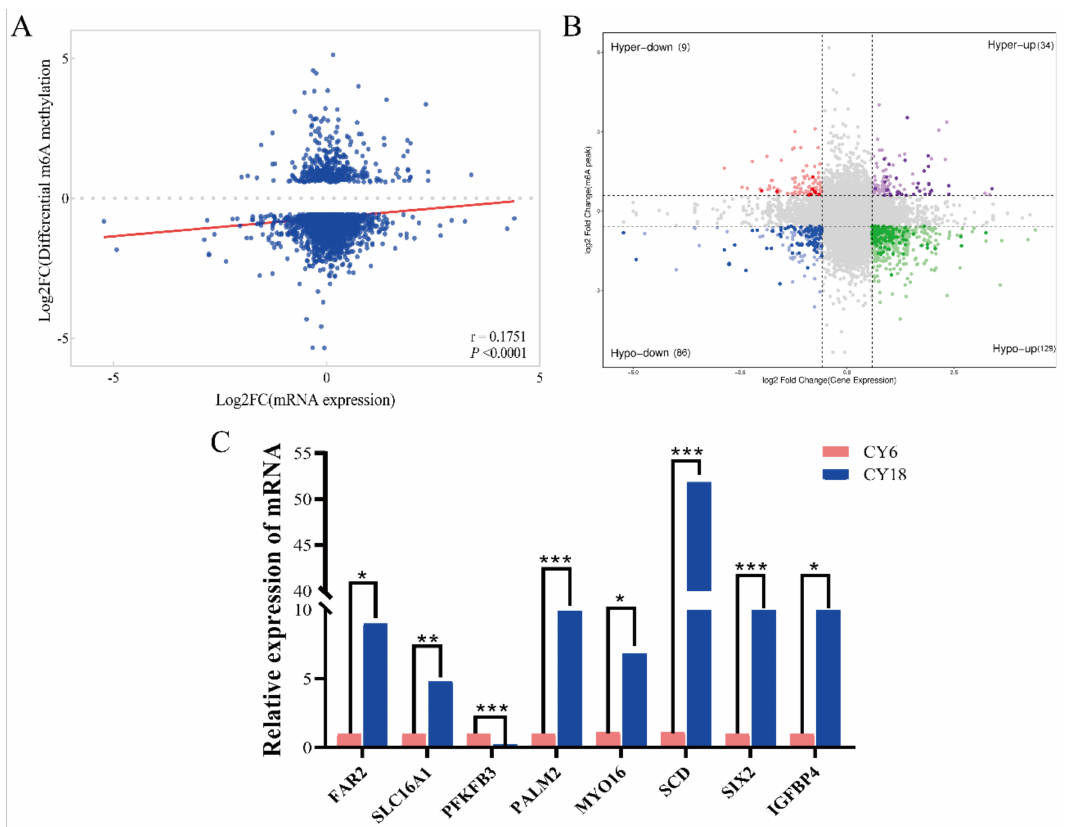
Figure 5. Integrated analysis of DEPs and DEGs: ( A ) positive correlation between m 6 A methylation and mRNA expression level (r = 0.1751, p < 0.001); ( B ) distribution of genes with a significant change in m 6 A methylation level and gene expression; ( C ) the results of qRT-PCR for verifying the RNA-seq data. “***” p < 0.001, “**” p < 0.01, “*” p <